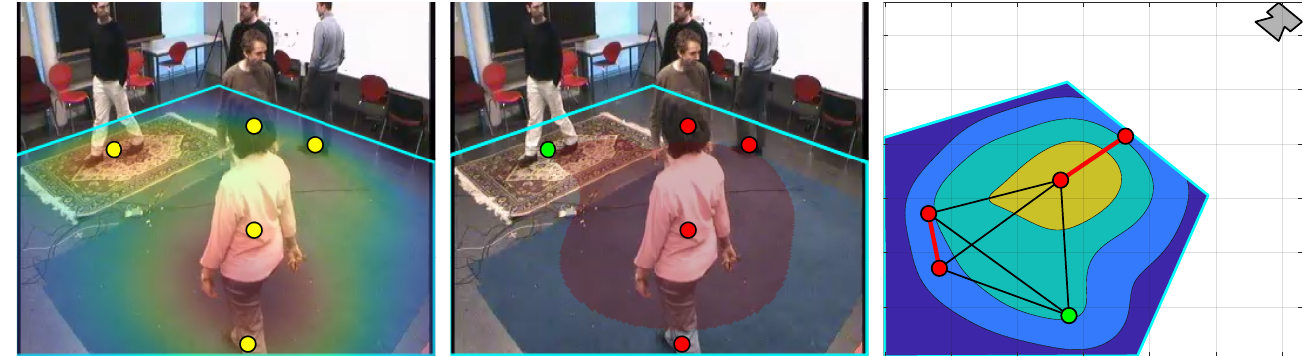
( a ) Integrated video frame with the subject local- ( b ) Integrated video frame showing the detected ( c ) Dynamic top-view map showing the local- ization and averaged occupancy density map. social distance violations and averaged thresh- ization, inter-personal distances, safety distance olded crowd density map. violations, and averaged crowd density map. Figure 6. The proposed system example integrated video frames and dynamic top-view maps using frames 1 to 1824 of the EPFL-MPV dataset scene 6p-c0. The type and amount of displayed information is adjustable and one can view multiple integrated frames and/or top-view maps simultaneously. Note that the pair-wise lines in ( c ) are plotted only for distances between 0 and 3 m to ease visualization.